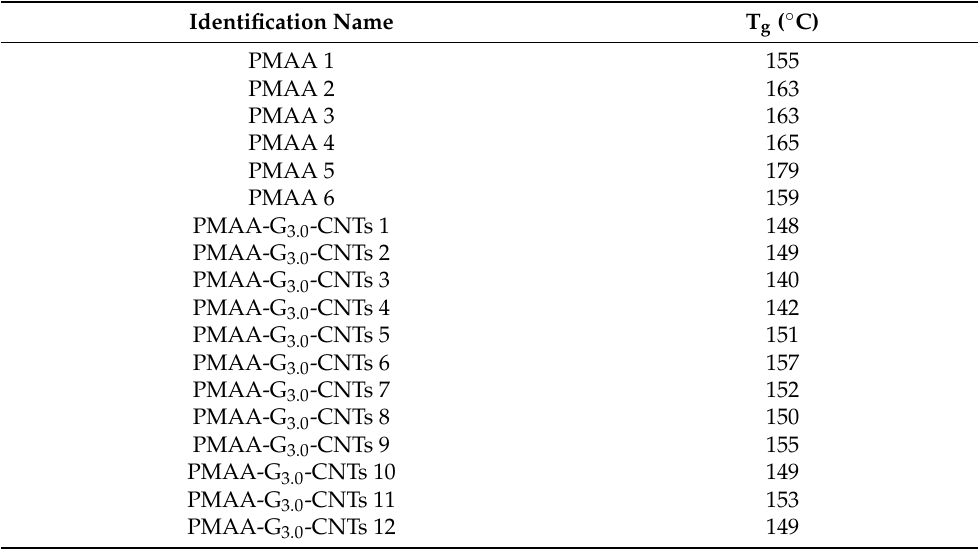
Table 3. Values of the glass transition temperature of the synthesized PMAAs and of their nanocom- posites.